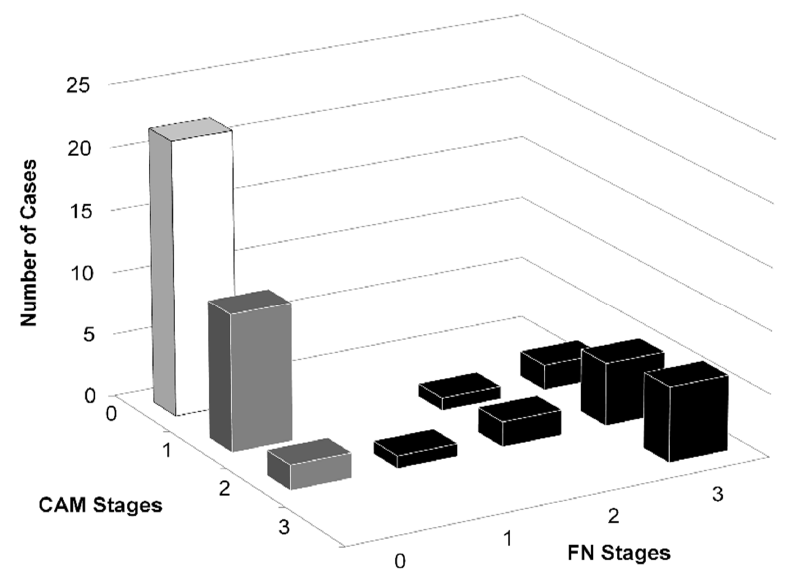
Figure 2. We studied a total of 52 newborns. This study group included 22 healthy newborns without funisitis (FN) or chorioamnionitis (CAM) as a control group (white column), 17 cases of FN (black column), and 13 cases of CAM (gray column). All members of the FN group suffered from CAM, while no member of the CAM group suffered from FN. A histological diagnosis of FN or CAM was made based on the degree of neutrophilic infiltration in stages I, II, and III using the Blanc classification [4].